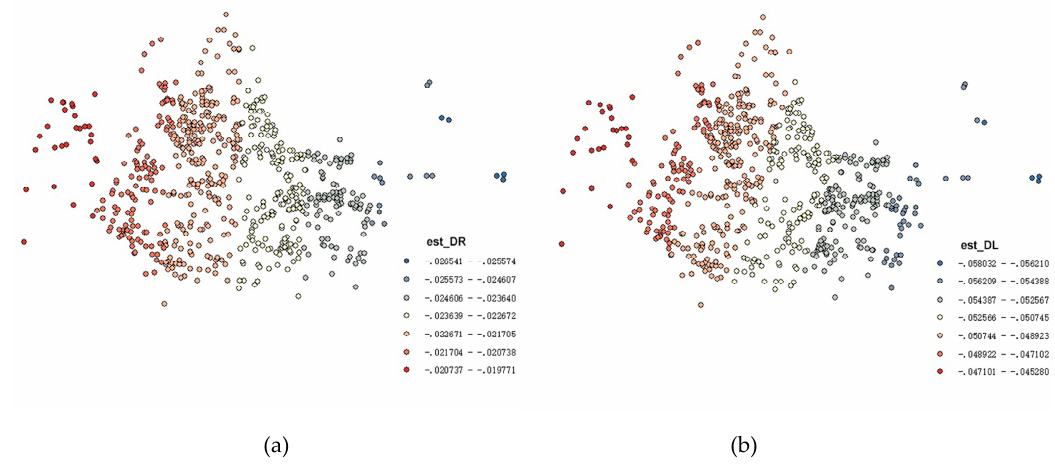
Figure 6. Regression coefficient distribution of distance to river ( a ) and lake ( b ).